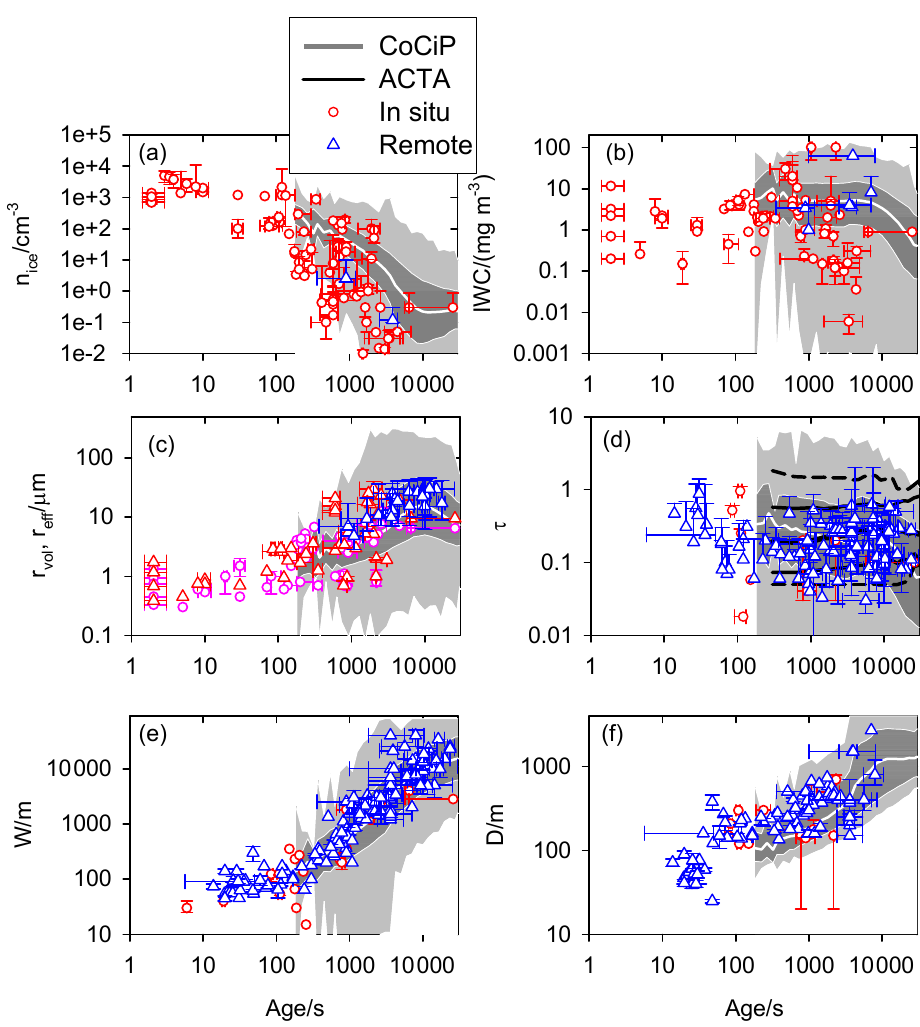
Figure 3. Local contrail parameters from all observations collected in COLI versus contrail age, together with results from a model simulation (CoCiP percentiles) as in Fig. 1. (a) n ice , (b) IWC, (c) r vol (purple symbols), r eff (red and blue symbols), (d) τ , (e) W , and (f) D . The red (and purple) symbols are from in situ measurements. The blue symbols are from remote sensing. The black lines in panel (d) are from